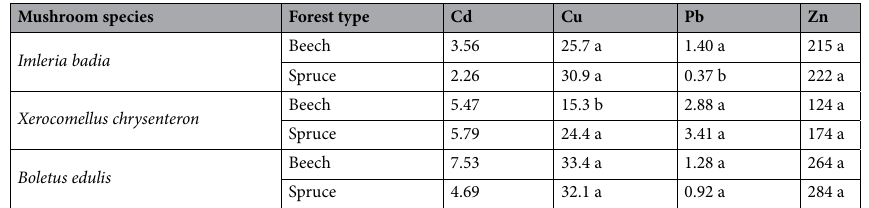
Table 3. Average PTE contents (mg/kg) of the most abundant mushroom species (> 5 samples for each forest type); different letters indicate significant differences in the PTE content of the species between forest types (Mann–Whitney U Test, p = 0.05).